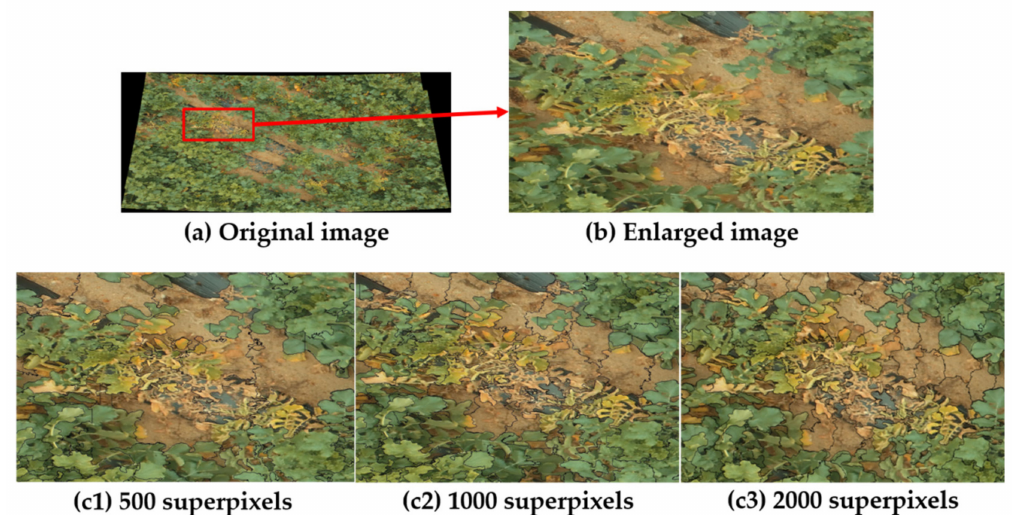
Figure 6. Superpixel segmentation with a di ff erent number of superpixels. We zoomed in a specific wilt region ( b ) on the original image ( a ). After that, the superpixel segmentation was applied to the zoom image with a di ff erent number of superpixels, which include ( c1 ) 500 superpixels, ( c2 ) 1000 superpixels, and ( c3 ) 2000